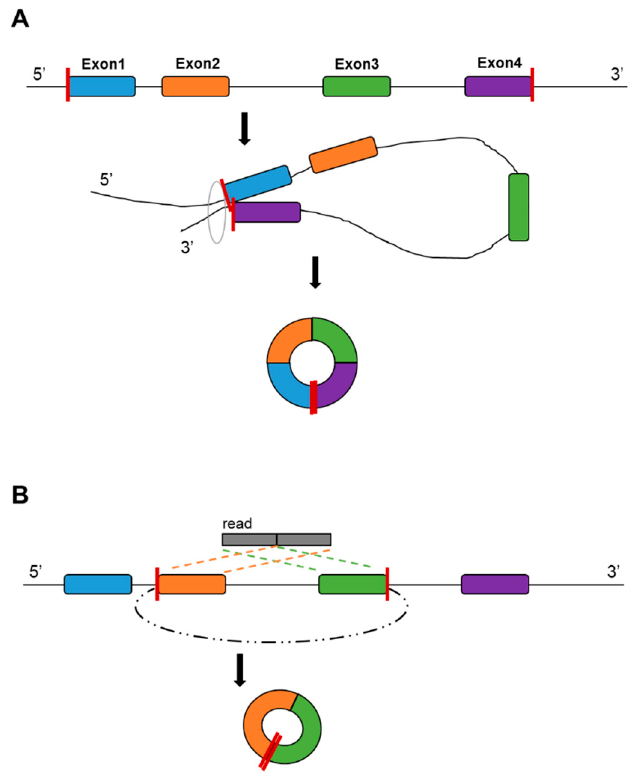
Figure 3. Formation of circular RNA. A. Direct ligation of 5’ and 3’ of the RNA; B. Backsplicing between exons. Table 2. circRNA identification